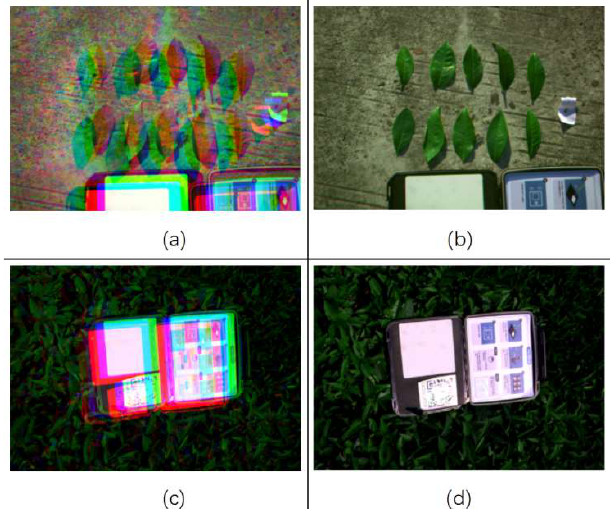
Figure 5. Comparison before and after registration. ( a ) Before leaf-scale multispectral image regis- tration and fusion; ( b ) after leaf-scale multispectral image registration and fusion; ( c ) canopy-scale multispectral image before registration and fusion; and ( d ) canopy-scale multispectral image after registration and fusion.